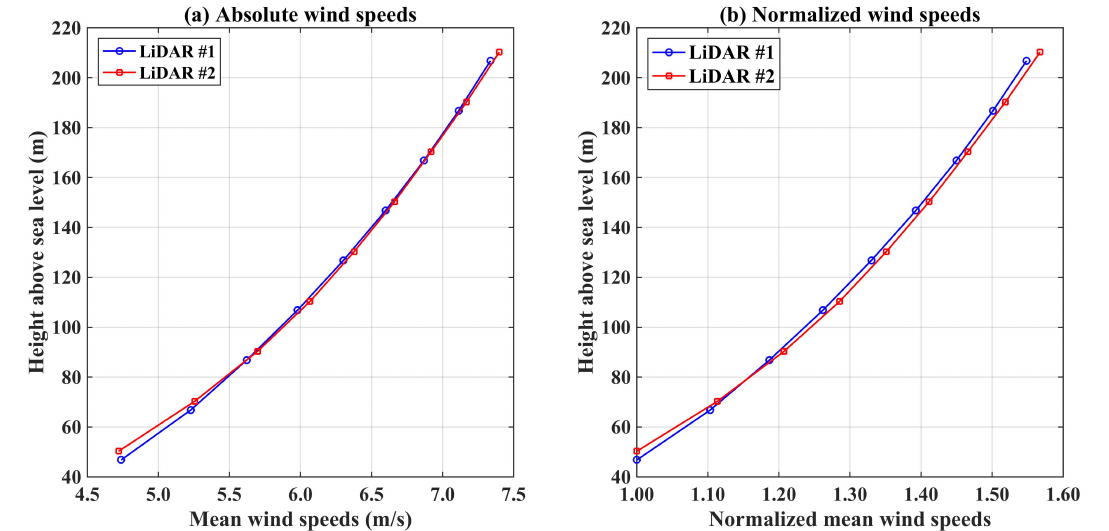
Figure 16. ( a ) Absolute mean wind speed profiles and ( b ) mean wind speed profiles normalized by the lowest level values for land sectors (215 ◦ to 325 ◦ ) at the HORS research platform. Only observations that were taken when all heights were available were used for this